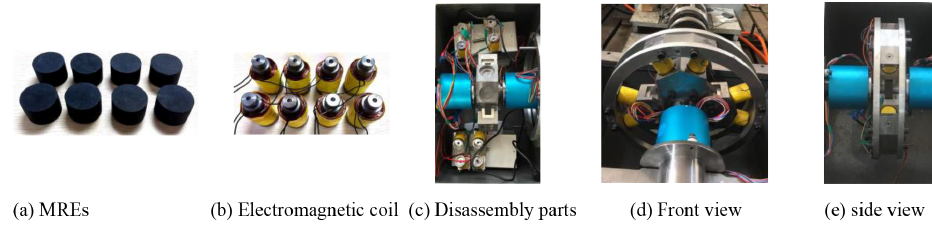
Figure 12. Principle prototype of the MRE vibration absorber. Table 5. Magnetic field parameters of the fan-shaped structure.